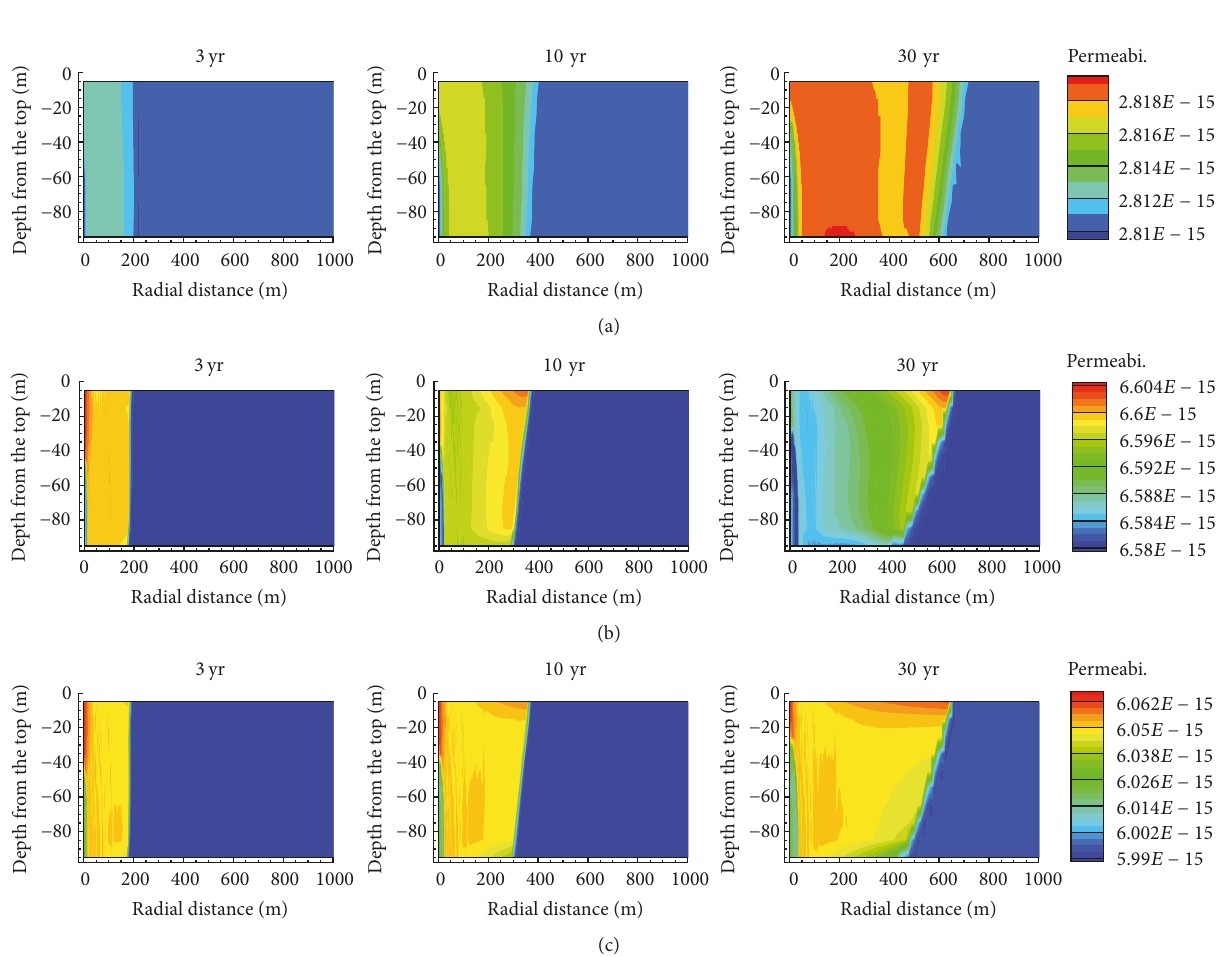
because that permeability is calculated from porosity using